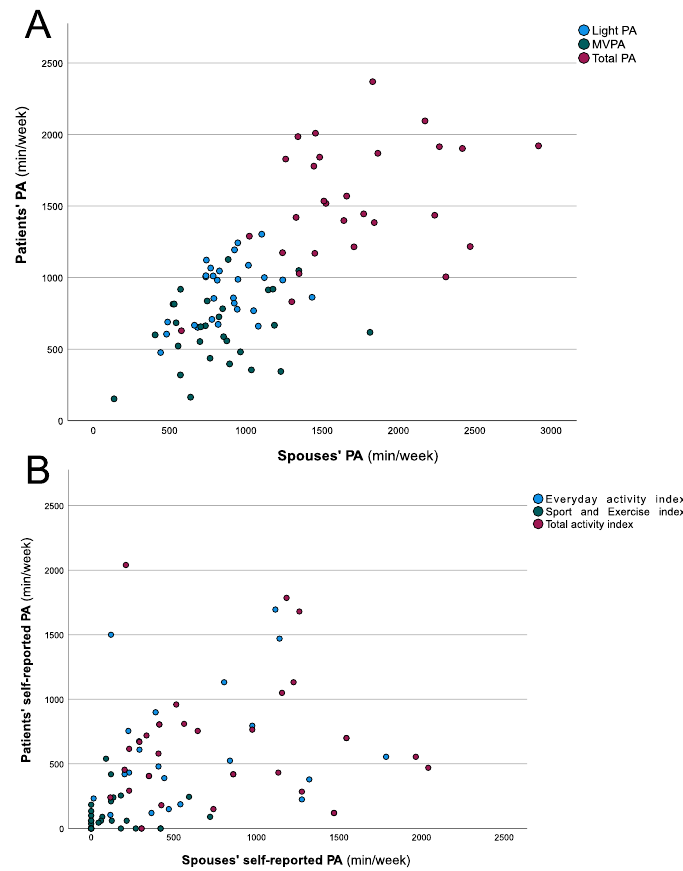
Figure 1. Correlation analyses of the patients’ and their spouses’ PA. ( A ) Scatterplot of the participants’ PA based on accelerometer data. The partial correlations (controlled for the couple-specific deviations in BMI) of weekly light PA and total PA revealed significant results (r ≥ 0.331, p ≤ 0.046), whereas MVPA showed no significant results (r = 0.257, p = 0.097). ( B ) Scatterplot of the participants’ weekly PA based on self-reported data. The partial correlations of everyday activity, sport, and exercise and total activity indices showed no significant results (r ≤ 0.046, p ≥ 0.409).